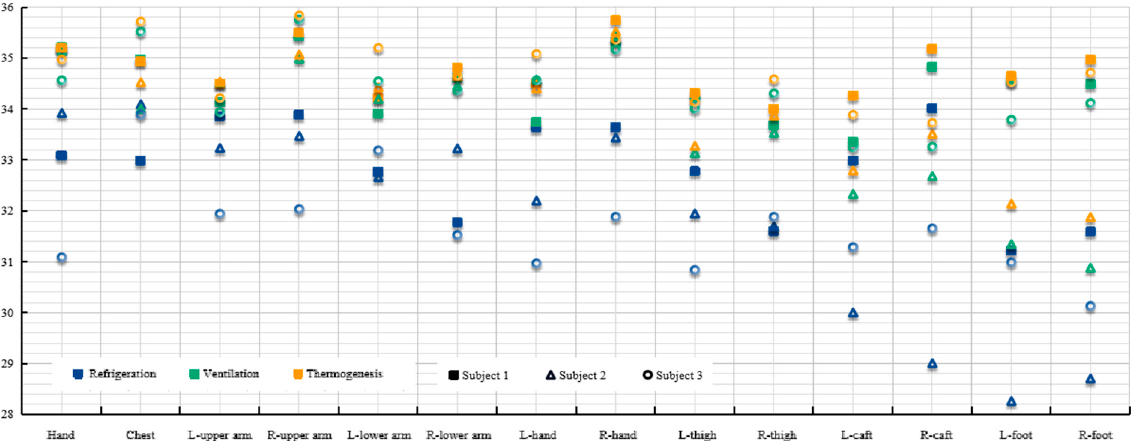
Figure 13. Temperature distributions of the three subjects wearing short clothing, at each measuring point, under three working conditions.